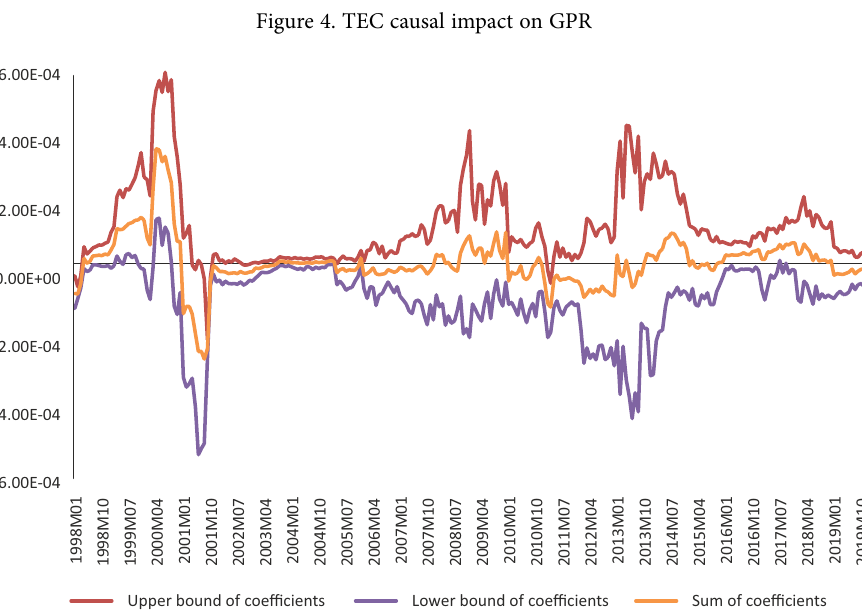
Figure 5. The direction of TEC impact on